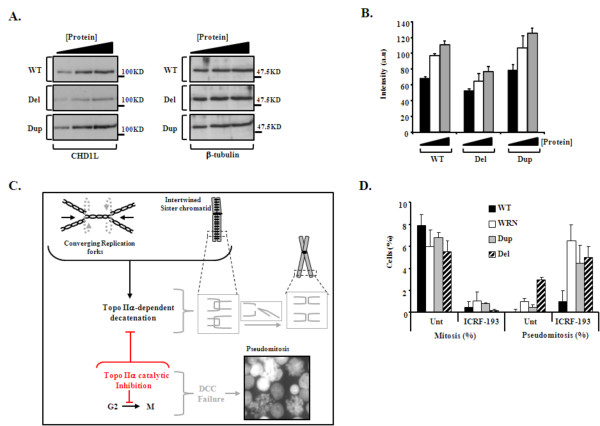
Functional assays for CHD1L in patient cells. (A) Left panels: Western analysis of CHD1L expression from wild-type (WT), 1q21.1 deletion (Del) and duplication (Dup) LBCs following titration of whole cell extracts. Right Panels: β-tubulin re-probe to confirm equal loading. (B). Densiometric quantification of CHD1L expression from Western analysis from low (black bar), intermediate (white) to higher (grey) amounts of protein, from each line, using three separate determinations, normalized to β-tubulin loading (a.u. arbitrary units). p = 0.009 for Del and p < 0.005 for Dup compared to WT. (C). The Decatenation Checkpoint (DCC). Unreplicated DNA sequences between converging replication forks undergo catenation and torsional tension which is normally relieved by Topoisomerase IIα (Topo IIα) which induces a transient DSB enabling decatenation (untangling). DCC activation in G2 prevents entry into mitosis until sister chromatids are fully separated. DCC can be activated by Topo II inhibitors arresting the cycle in G2 (indicated in red). DCC failure is monitored by the enumeration of 'pseudomitosis' containing highly catenated (entangled) chromatids. Inset image shows typical pseudomitotic cells following treatment of the Del LBCs with the Topo II inhibitor, ICRF-193. (D). Mitotic index (Mitosis %) and Pseudomitotic index (Pseudomitosis %) for untreated (Unt) LBCs or ICRF-193 treated, for wild-type (WT), Werner's syndrome (WRN), Dup and Del containing LBCs. WRN LBCs are known to be defective in DCC activation. Data presented indicates the mean ± s.d of three separate determinations. p < 0.005 for reduction in Mitosis (%) Unt compared to ICRF-193 and p < 0.005 for increase in Pseudomitosis (%) Unt compared to ICRF-193.